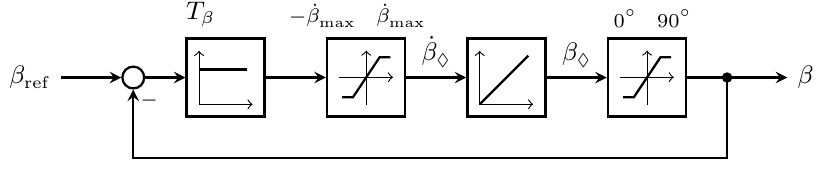
Figure 4. Block diagram of the approximated pitch system